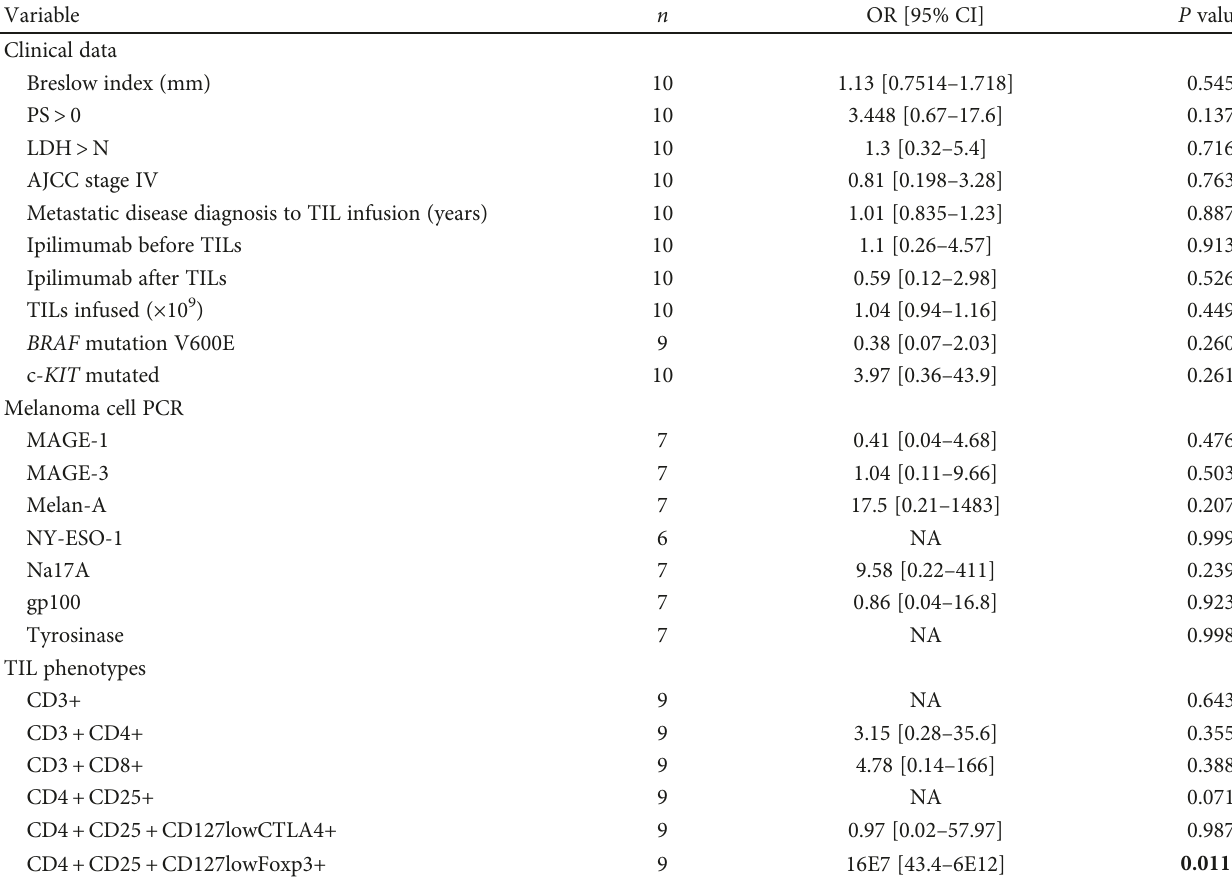
Table 4: Univariate analysis of overall survival.